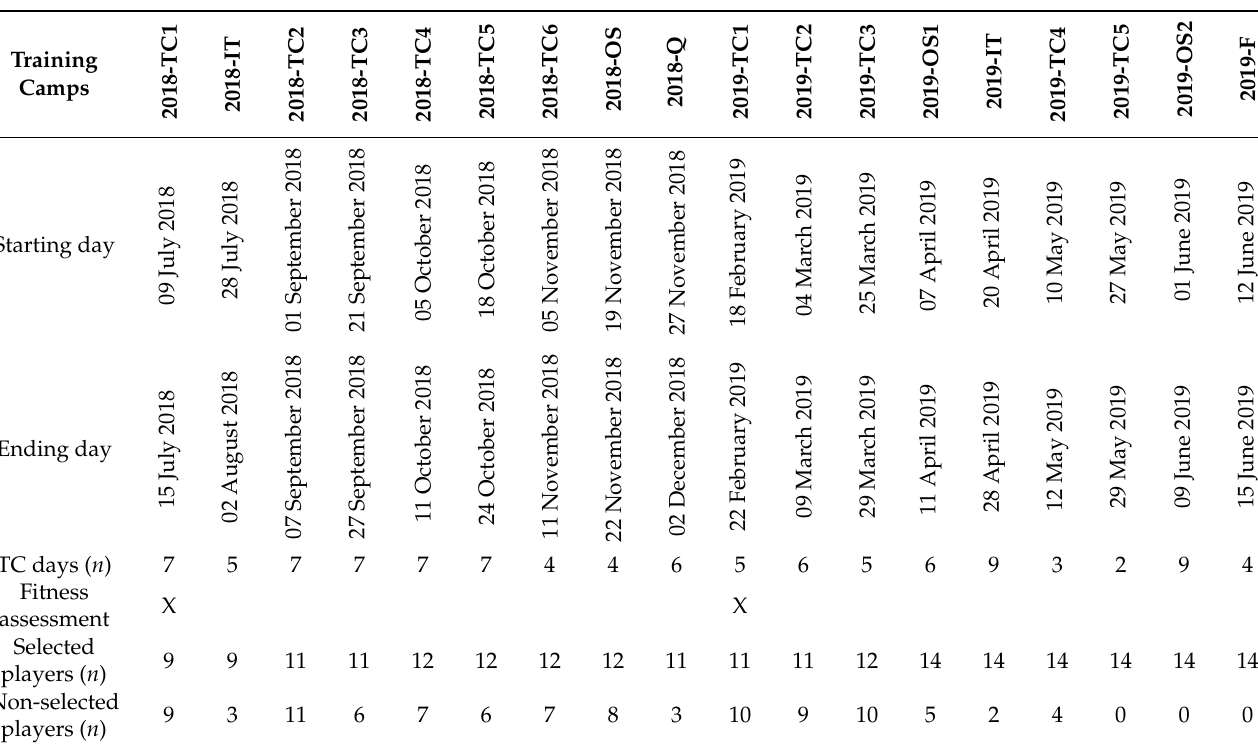
Table 1. Timeline of the